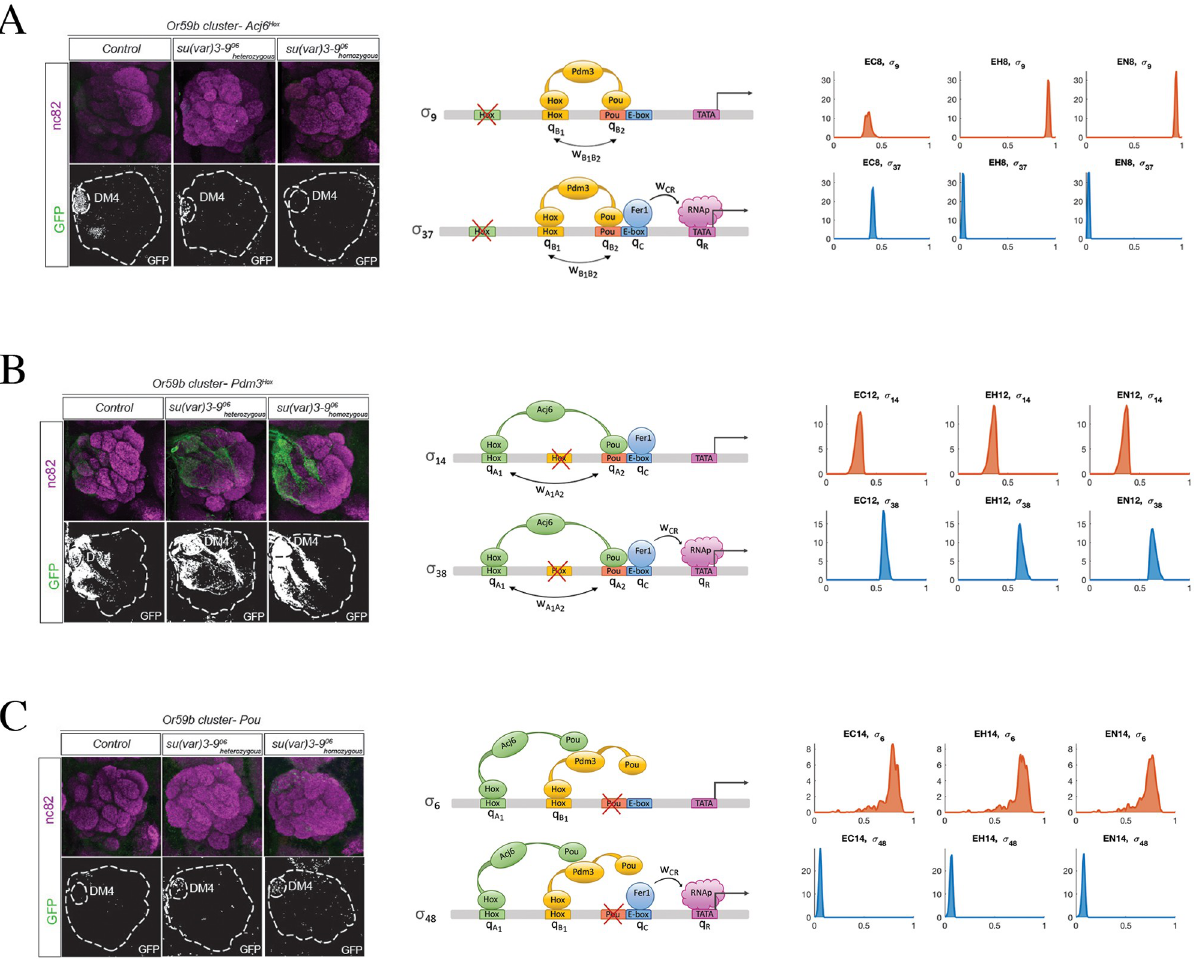
Fig 5. Single binding site mutants and their expression. (A): Mutation of Acj6Hox (i.e., E8 in Table 1). Left panel: GFP expression decreases passing from normal chromatin state (EC8) to heterozygous su(var)3-9 mutant (EH8) and to homozygous su(var)3-9 mutant (EN8). Middle panel: in our model, the two configuration states that contribute the most in this case are σ 9 and σ 37 . Right panel: the corresponding distributions of P ( σ 9 ) (no Or59b expression) and P ( σ 37 ) (expression, but very weak) are reported. See Fig. H of S1 Text for all 48 probability histograms. (B): Mutation of Pdm3Hox (i.e., E12 in Table 1). Left panel: GFP expression is very high on all 3 epigenetic conditions (ectopic expression is not considered in the paper). Middle panel: the on-state is σ 38 and the main off-state is σ 14 . Right panel: the on-state has a high probability: P ( σ 38 ). See Fig. J of S1 Text for complete histograms of all σ k . (C): Mutation of Pou motif (i.e., E14 in Table 1). Left panel: GFP expression increases slightly passing from normal chromatin state (EC14) to heterozygous su(var)3-9 mutant (EH14) and to homozygous su(var)3-9 mutant (EN14). Middle panel: the main on-state is σ 48 and the main off-state is σ 6 . Right panel: the probability of the on-state, i.e. P ( σ 38 ) slightly increases passing from EC14 to EH14 and to EN14. See Fig. K of S1 Text for complete histograms of all σ k